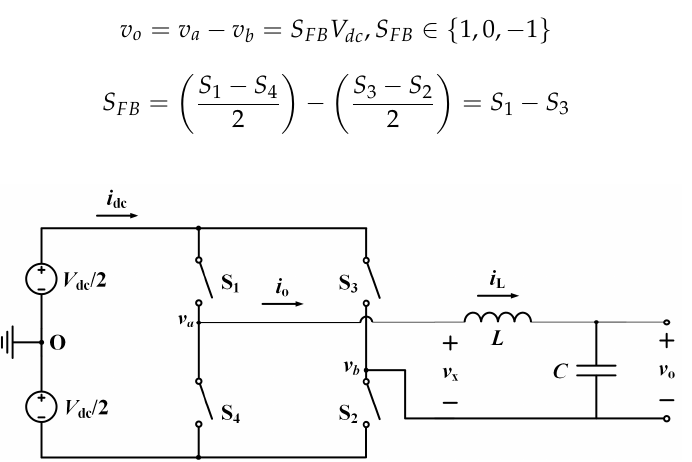
Figure 4. Equivalent circuit model of single-phase full-bridge inverter.